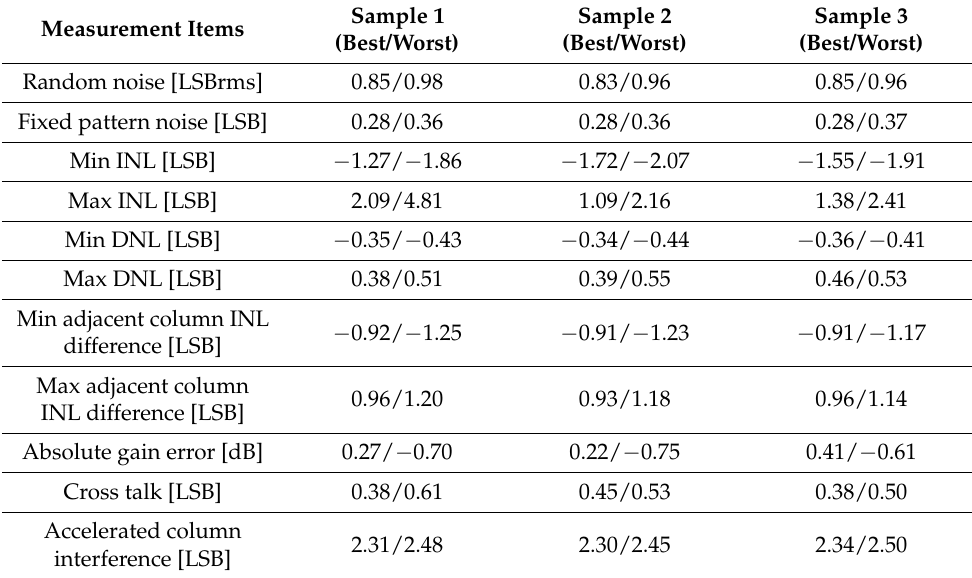
Table 1. ADC electrical characteristics evaluation results.